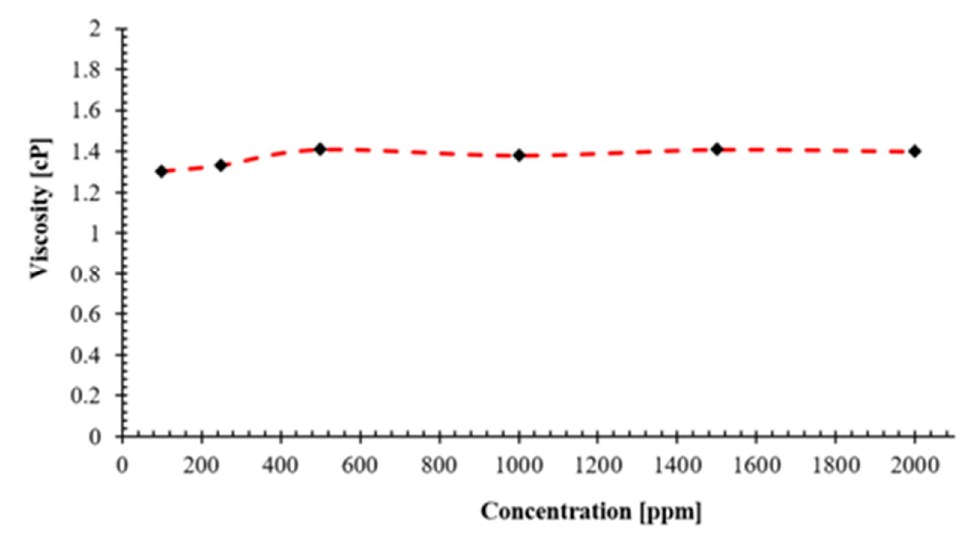
Figure 10. Viscosity values determined for the nanofluids prepared using di ff erent concentrations of the novel NC (100–2000 ppm). The viscosity of the prepared nanofluids is almost constant at di ff erent concentrations of the novel NC. Nanomaterials 2020 , 10 , x